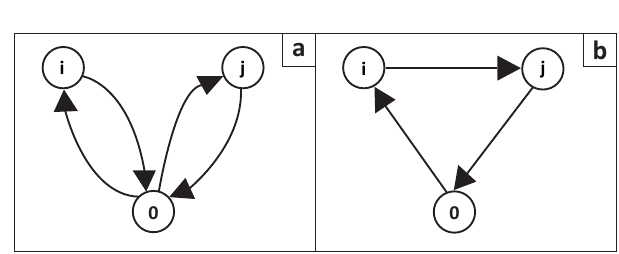
FIGURE 1: Illustration of the savings